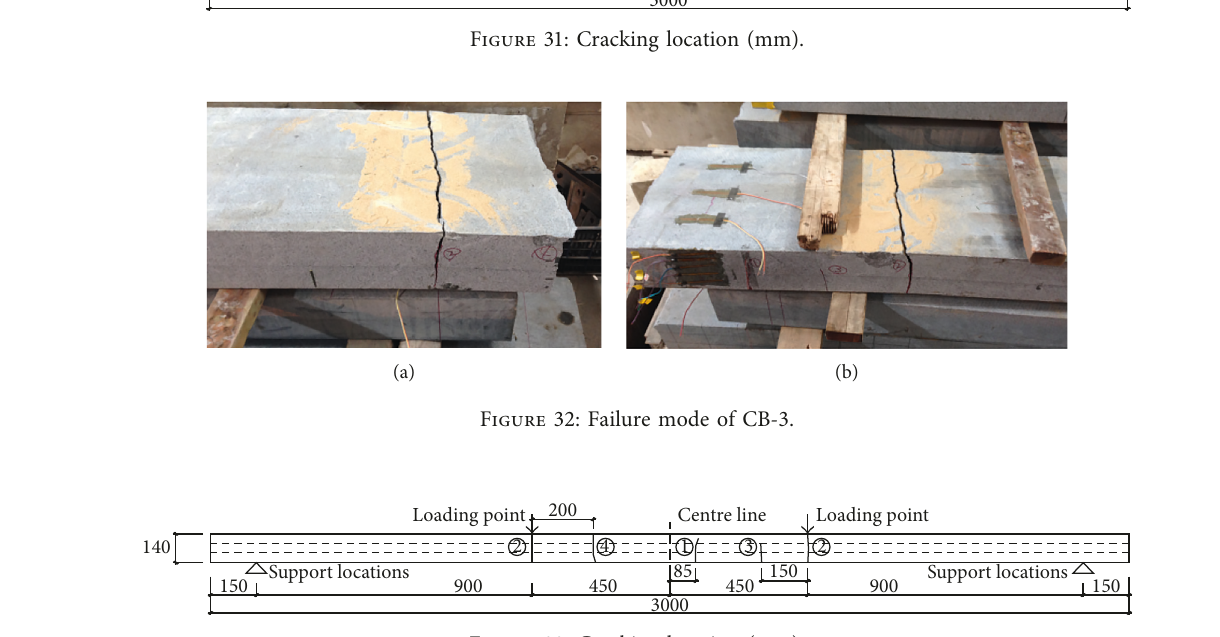
Figure 31: Cracking location (mm).